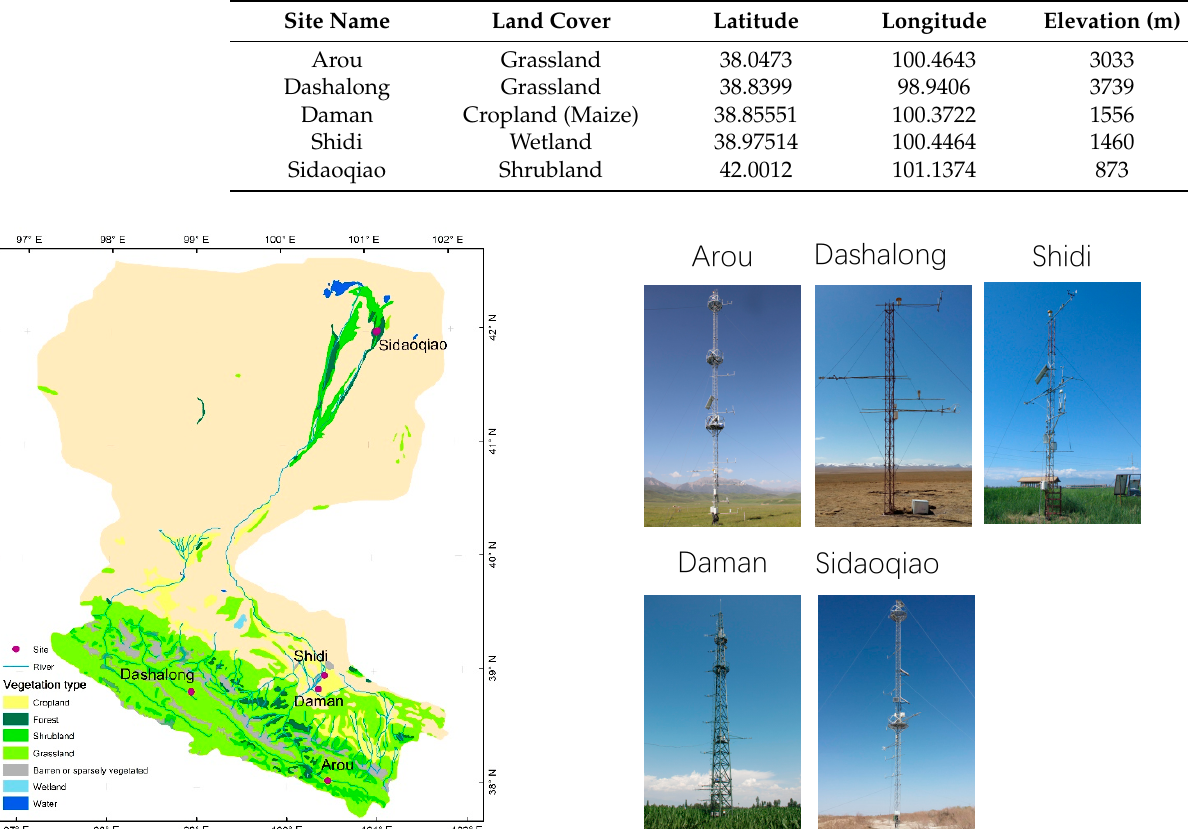
Table 1. Information of the Eddy Covariance (EC) sites in the Heihe River Basin.